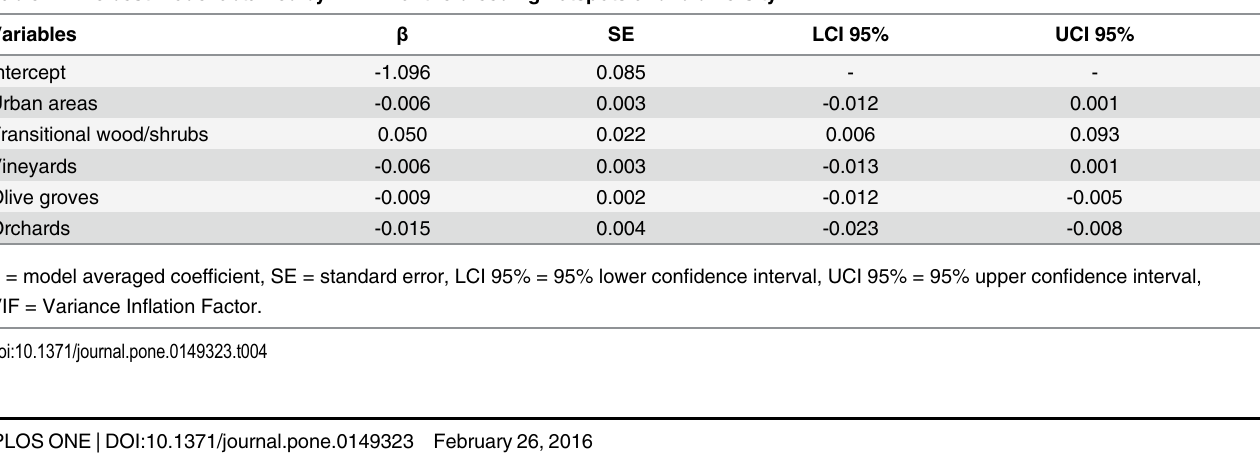
Table 4. The best model obtained by MLRA for the breeding hotspots of bird